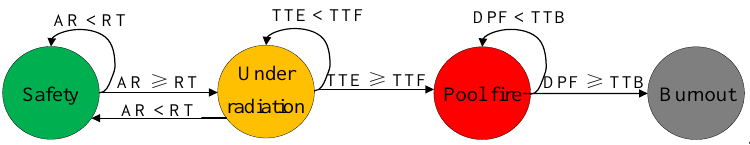
Figure 2. Dynamic evolution process of fire domino effect.